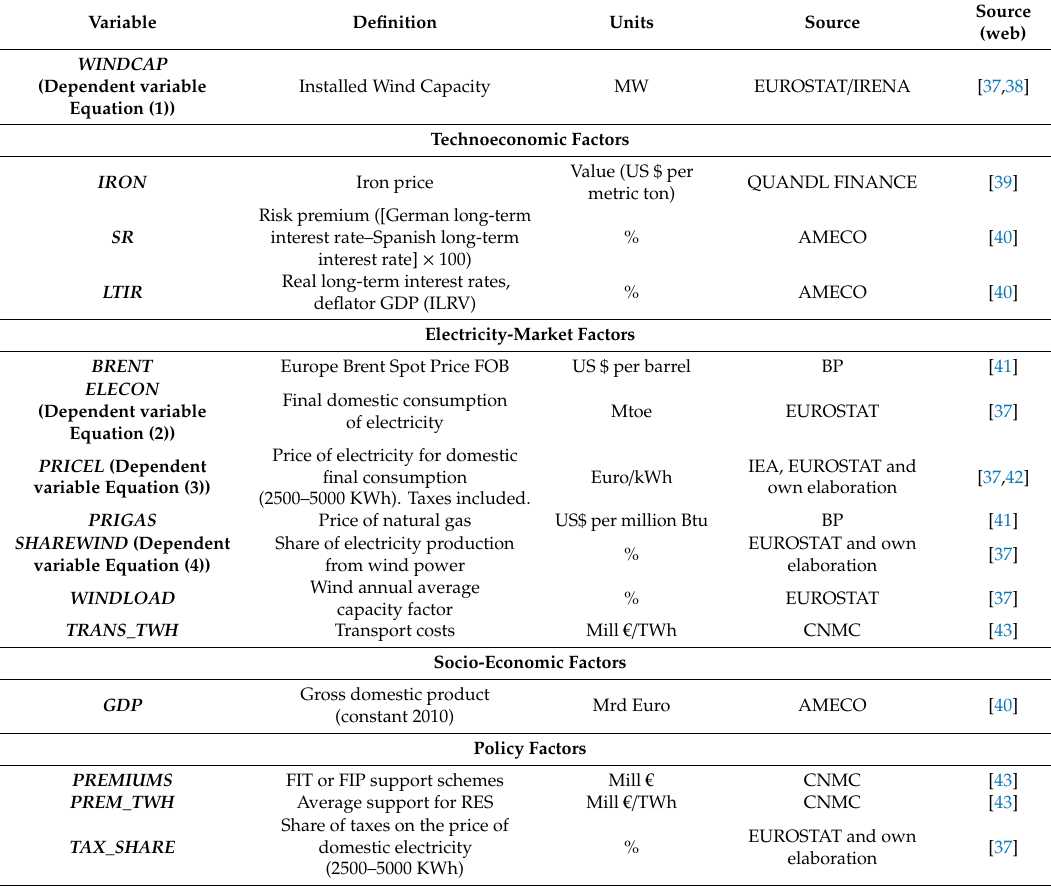
Table 3. Factors determining the increase in wind installed